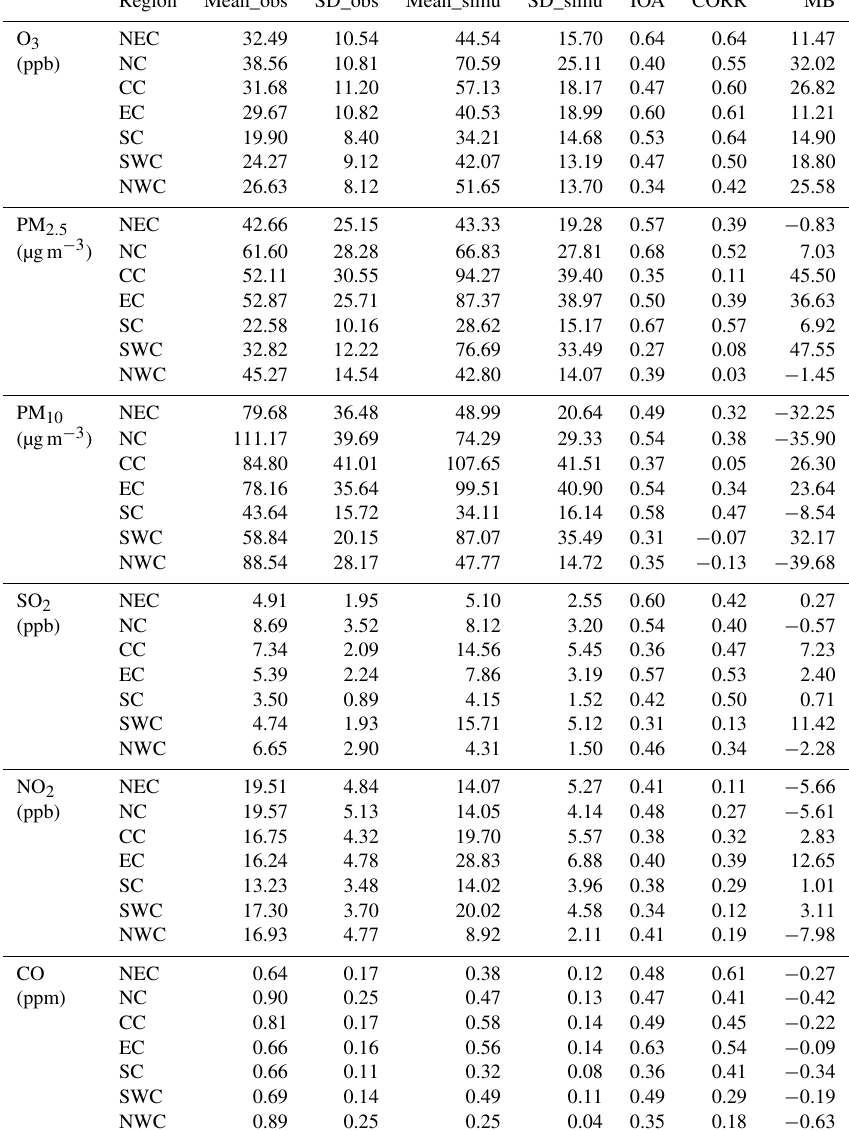
Table 6. Evaluation results of air pollutants in seven major geographic regions simulated by the implemented model. NEC is northeast China, NC is north China, CC is central China, EC is east China, SC is south China, SWC indicates southwest China, and NWC is northwest China. Mean_obs (Mean_simu) is the mean value of observations (model simulations); SD_obs (SD_simu) is the standard deviation of the observations (model simulations); IOA is the index of agreement; CORR is the correlation coefficient; MB is the mean